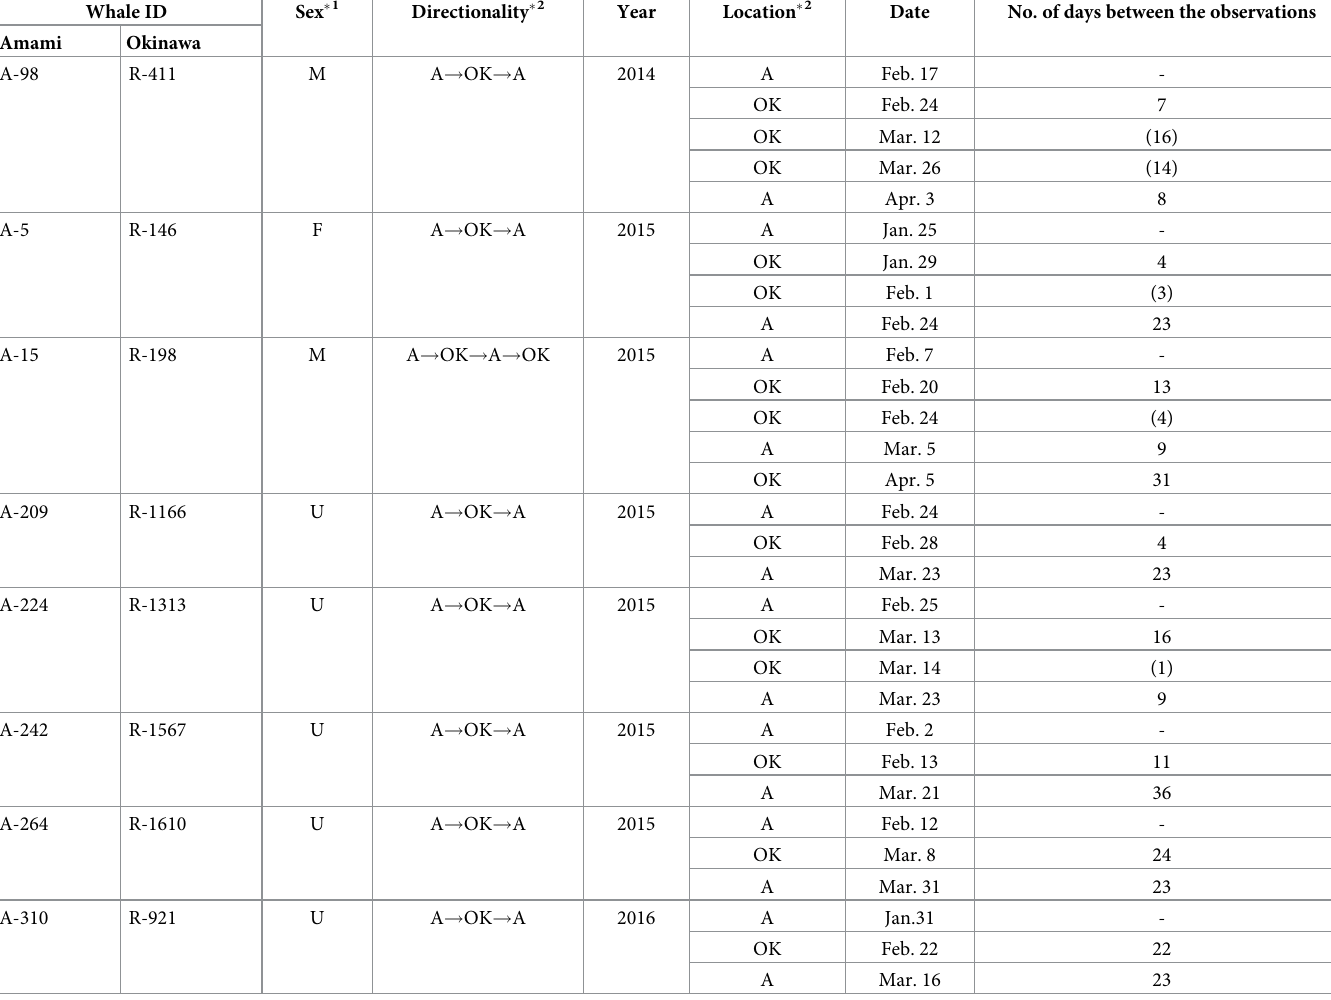
Table 7. Details of movement of whales between Amami and Okinawa observed for multiple times within the same season. Numbers in parenthesis are the number of days between the observations within the same area (Okinawa). Whale